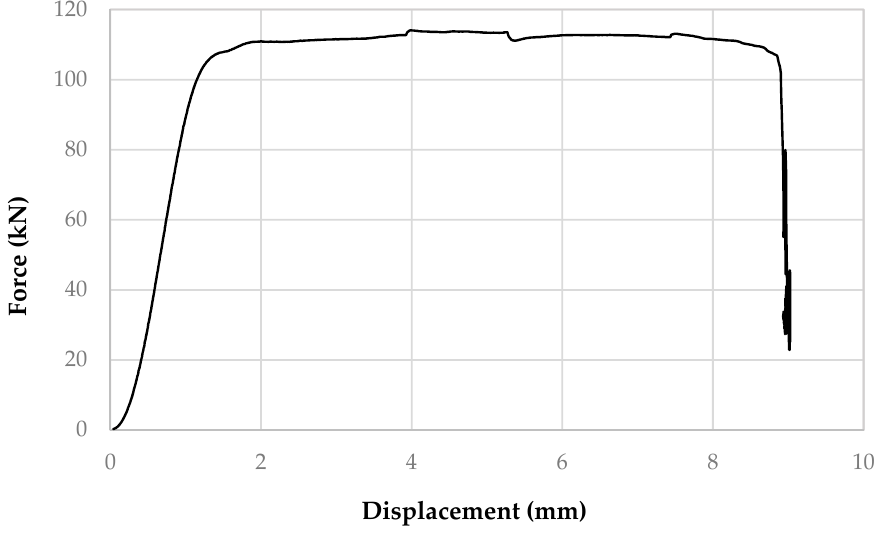
Figure 8. Compression-shear test.